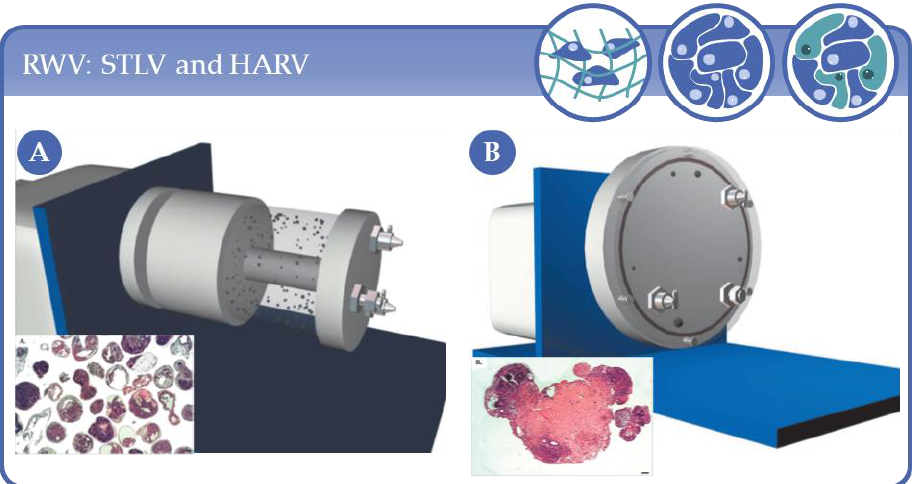
Figure 8. Diagram of two types of rotating wall vessel (RWV) bioreactors. ( A ) Slow turning lateral vessel (STLV) for formation of smaller cell aggregates (in this case small human embryoid bodies). ( B ) Usage of a high aspect rotating vessel (HARV) bioreactor leads to agglomeration of big cellular clumps. Reprinted from [45] with permission of John Wiley and Sons.